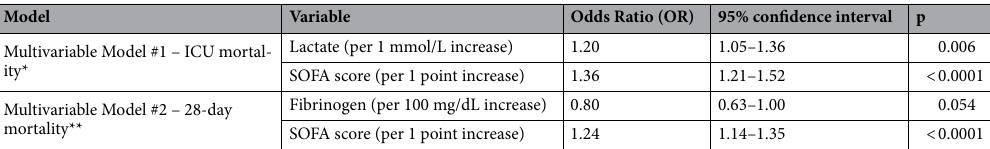
Table 4. Multivariable logistic regression analysis for ICU and 28-day mortality. *Variables included in backward selection process: soluble urokinase plasminogen activator receptor (suPAR) per doubling, procalcitonin, sequential organ failure assessment (SOFA) score, white blood count, international normalized ratio (INR), albumin, interleukin-6, lactate, high-density lipoprotein cholesterol (HDL-C), fibrinogen. **Variables included in backward selection process: suPAR per doubling, SOFA score, white blood count, albumin, lactate, HDL-C,